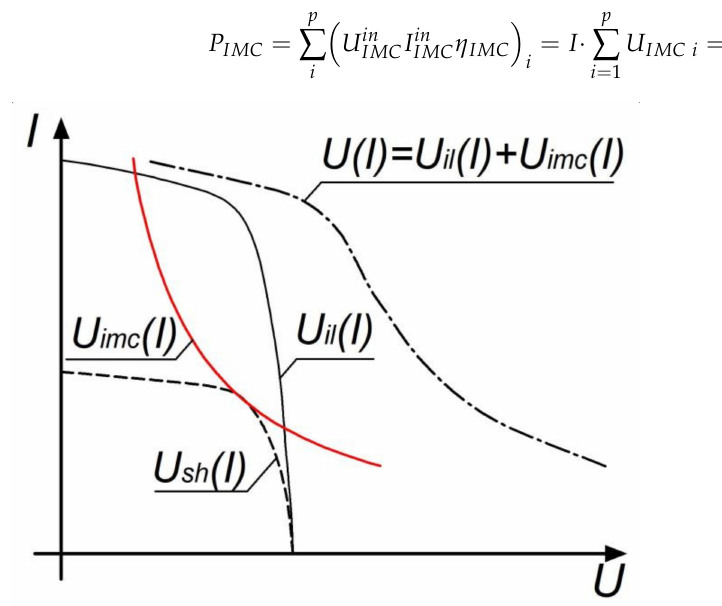
Figure 6. Current-voltage characteristic of a group of solar cells using an individual matching